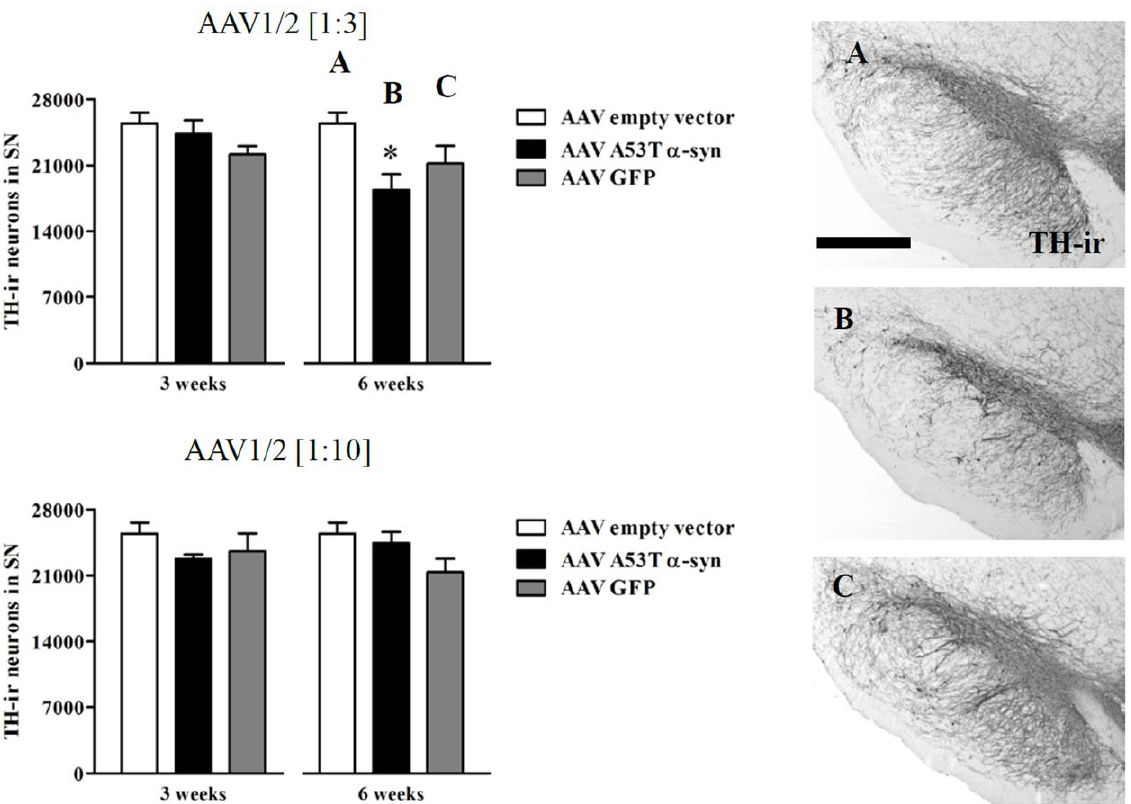
Figure 3. Dopamine neuron loss in the substantia nigra. Stereological counting of TH-ir neurons in the substantia nigra (SN) showed that AAV1/2 A53T a -synuclein (1:3, 1.7 6 10 12 gp/ml) reduces the number of dopamine neurons 6 weeks following intra-nigral injection, while quantification at 3 weeks or when using the 1:10 dilution (5.1 6 10 11 gp/ml) at either timepoint, showed no evidence of neuron loss. Panels A, B and C represent significant comparisons found in the AAV1/2 [1:3] graphs. Scale bar in panel A is 1000 m m. * P , 0.05 c.f. empty vector.